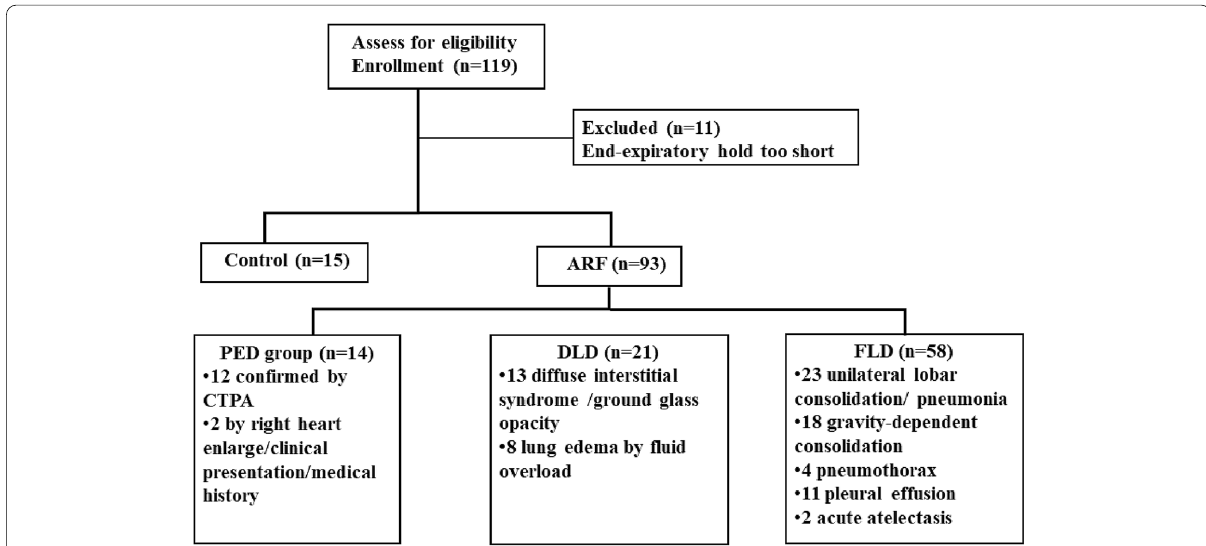
Fig. 1 Flow chart of the enrolled patients. The control group was postoperative ICU patients without acute respiratory failure; ARF: acute respiratory failure; PED group: patients with pulmonary embolism-related disease; DLD group: patients with diffuse lung involvement disease; FLD group: patients with focal lung involvement disease; CTPA: CT pulmonary angiography